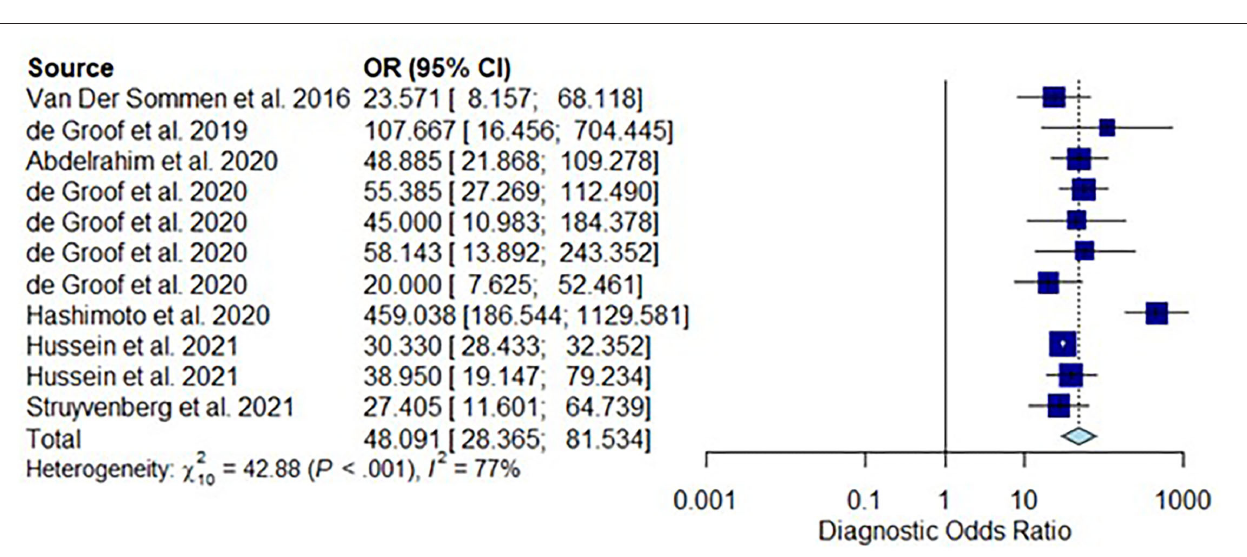
Frontiers in Medicine |